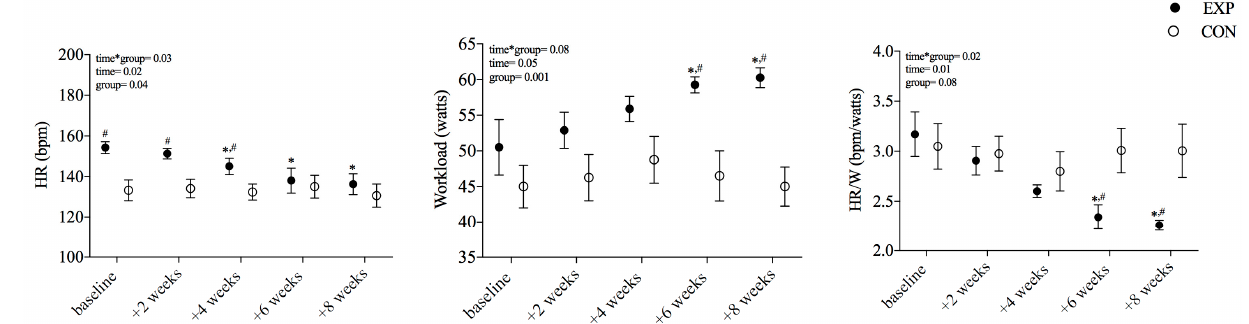
Figure 2. Workload and heart rate responses to rowing stepwise exercise during rowing exercise training. A. Workload (watts) and B. heart rate adjusted for power (bpm/watts) for every week of training. Measures were obtained during the last stage of the Rowing Stepwise Exercise test. ANOVA with repeated measures in the time factor. Sidak’s post hoc. Mean ± SD. EXP: experimental group; CON: control group. * Differences from baseline. # Differences between groups.